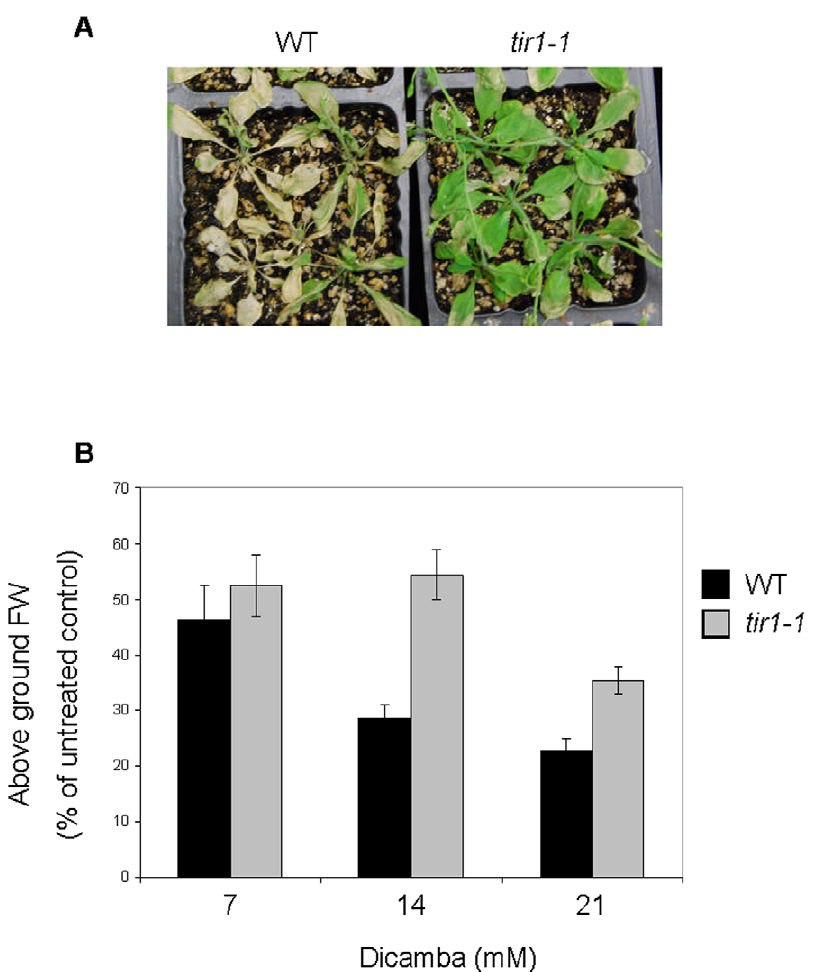
Figure 4. Effects of the foliar application of dicamba treatments on Arabidopsis plants. A, Representative photo showing the effects of dicamba treatment on 3 week old plants. Photo taken 3 days after a 14 mM dicamba treatment on WT and tir1-1 . The experiment was repeated twice with similar results. B, The effects of foliar applications of dicamba on the above ground fresh weight of WT and tir1-1 plants. Weights measured three days after treatment with 30 ml of 7, 14, and 21 mM dicamba. The change in above ground fresh weight is represented as a percentage of the weight of untreated control plants. There were 20 plants for each treatment, with the experiment repeated twice. (Error bars = standard error)